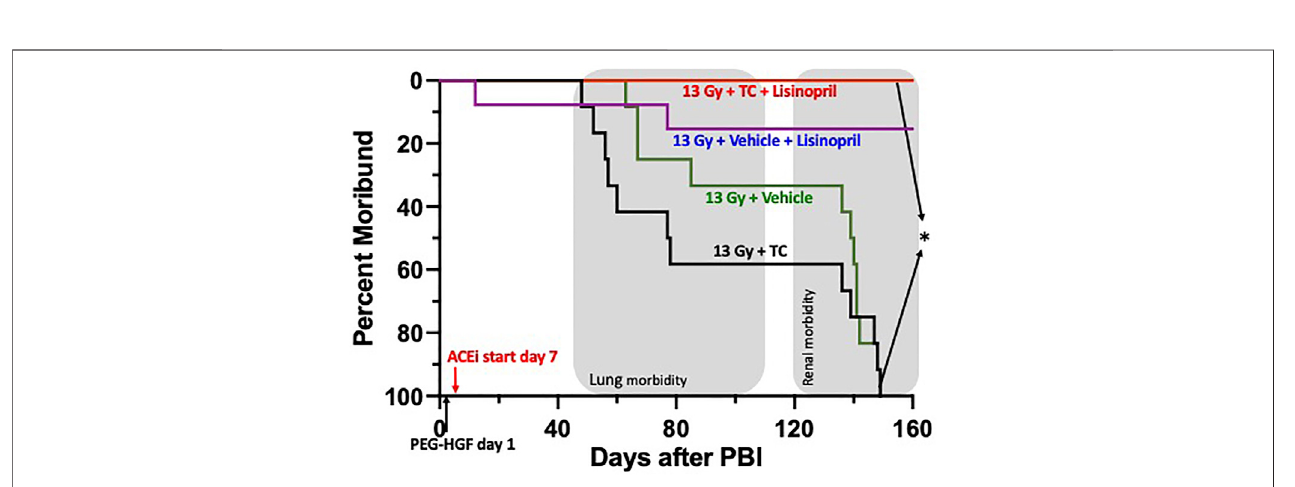
FIGURE 9 | Kaplan-Meier plot representing morbidity from DEARE up to 160 days post 13 Gy partial body irradiation with one hind limb shielded (legout PBI). The triplecombination(TC,consistingofPEG-hG-CSF,PEGmGMCSFandPEGhIL-11),orvehicleweregivensubcutaneously24 hpostPBIandtheACEinhibitor,lisinopril, wasstartedinthedrinkingwater7-dayspost-irradiation.Allirradiatedratsweregivensupportivecare.AllirradiatedratsthatreceivedTC+lisinoprilsurvivedto160 days as compared to 100% morbidity for irradiated rats that received TC alone ( p < 0.0001). Survival of irradiated rats given vehicle + lisinopril was over 90%, while irradiated rats given only the vehicle were moribund before 160 days. Shaded (gray) areas represent the timing for the lung and renal